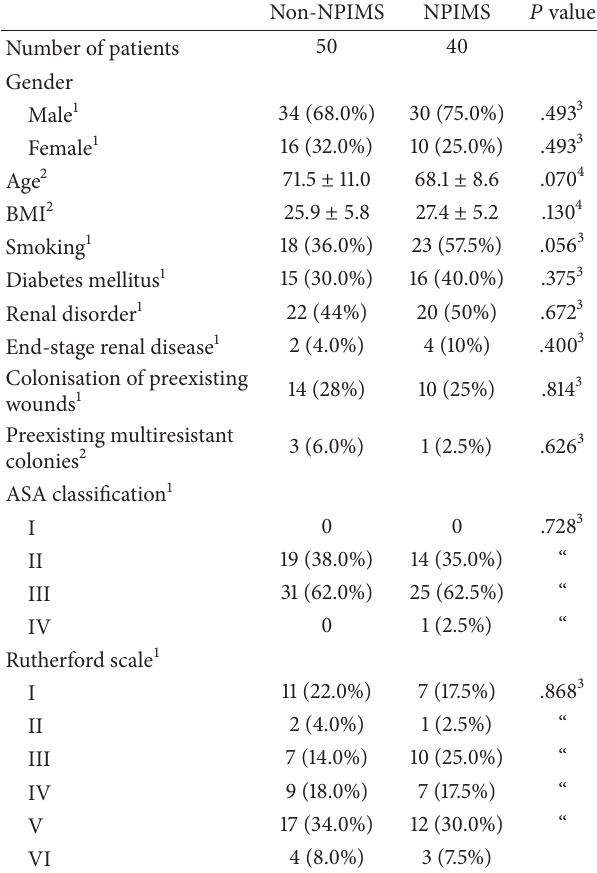
BMI: body mass index. ASA classification: American Society of Anaesthesiologists’ classification